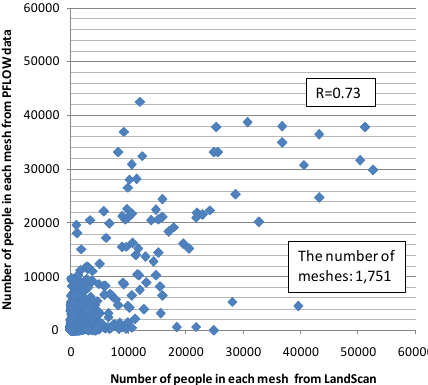
Figure 8. Correlation between PFLOW data and Land Scan data of each mesh.